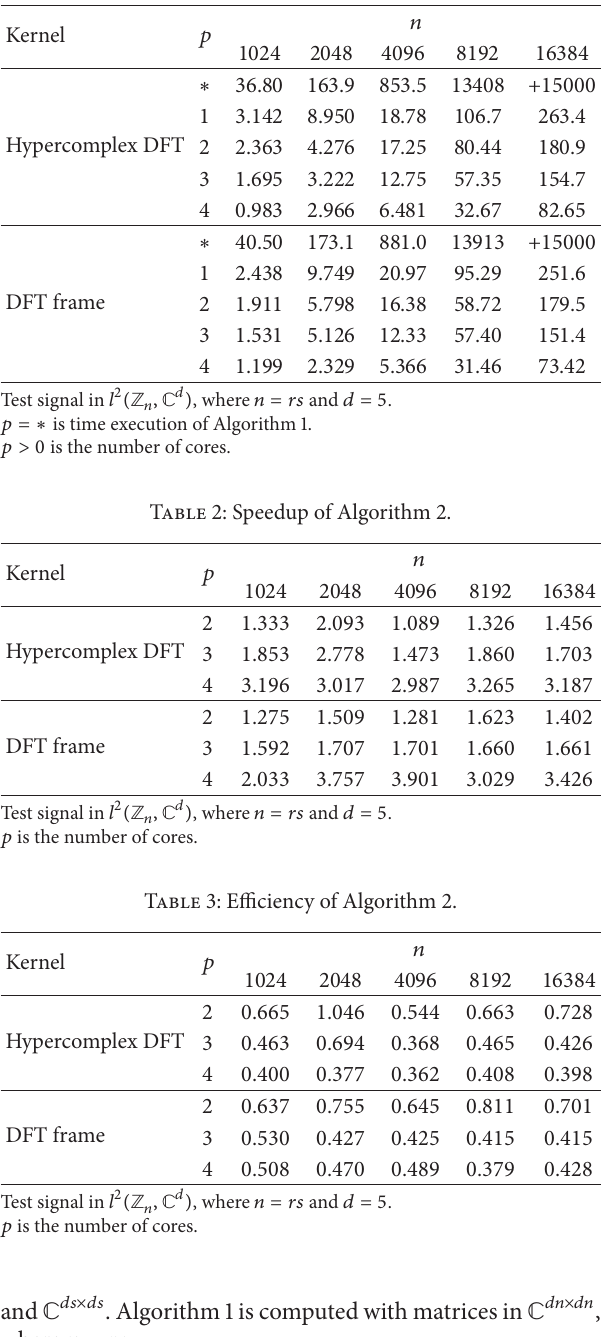
Table 1: Computing time of Algorithms 1 and 2 (in seconds).